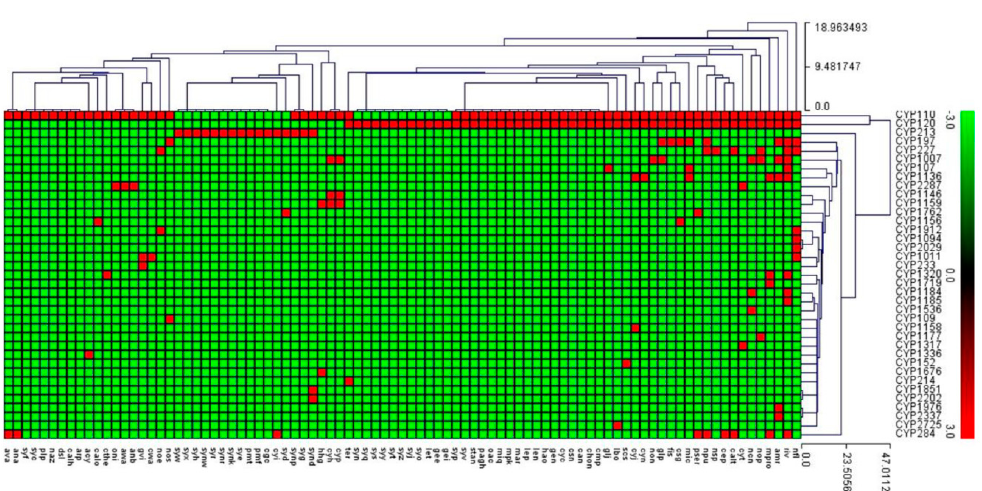
Figure 5. Heat-map of the presence/absence of P450 families in 88 cyanobacterial species. The data is represented as 3 for family presence ( red ) and –3 for family absence ( green ). Eighty-nine cyanobacterial species form the horizontal axis and P450 family numbers form the vertical axis. A detailed table showing P450 family profiles in each of the cyanobacterial species is presented in